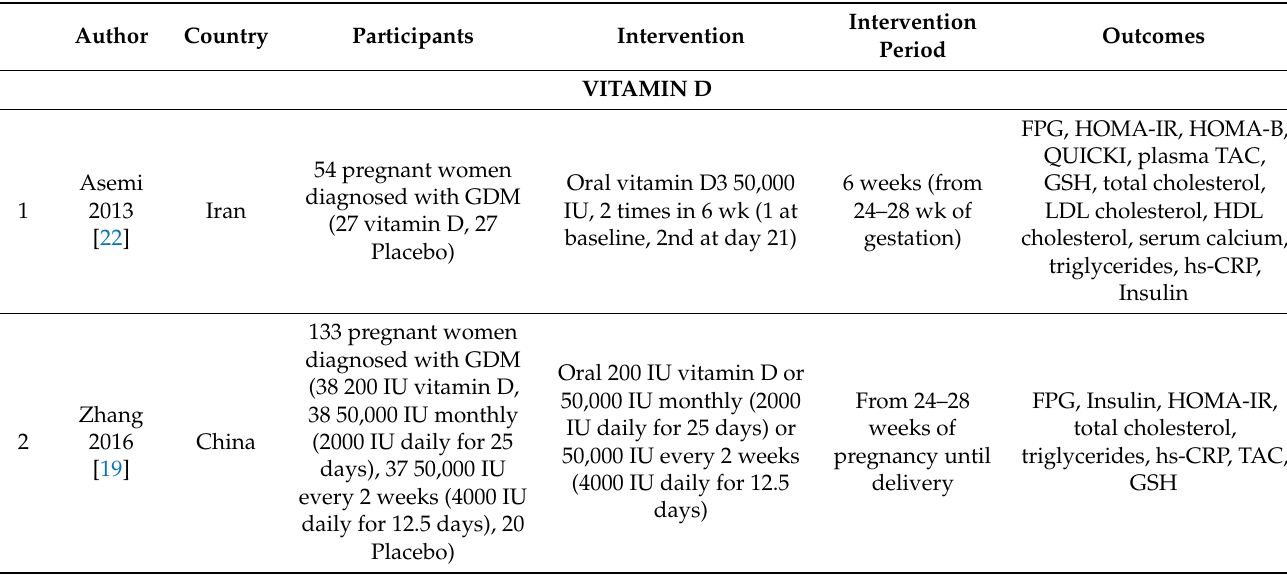
Figure 1. Flow chart of the different phases of the systematic review. Table 1. Characteristics of the included studies.